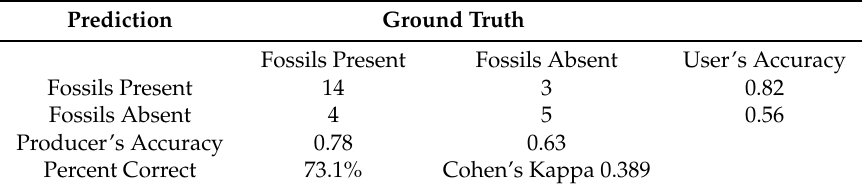
Table 2. Results of 2013 field season from the Freighter Gap/Pinnacles QuickBird image.